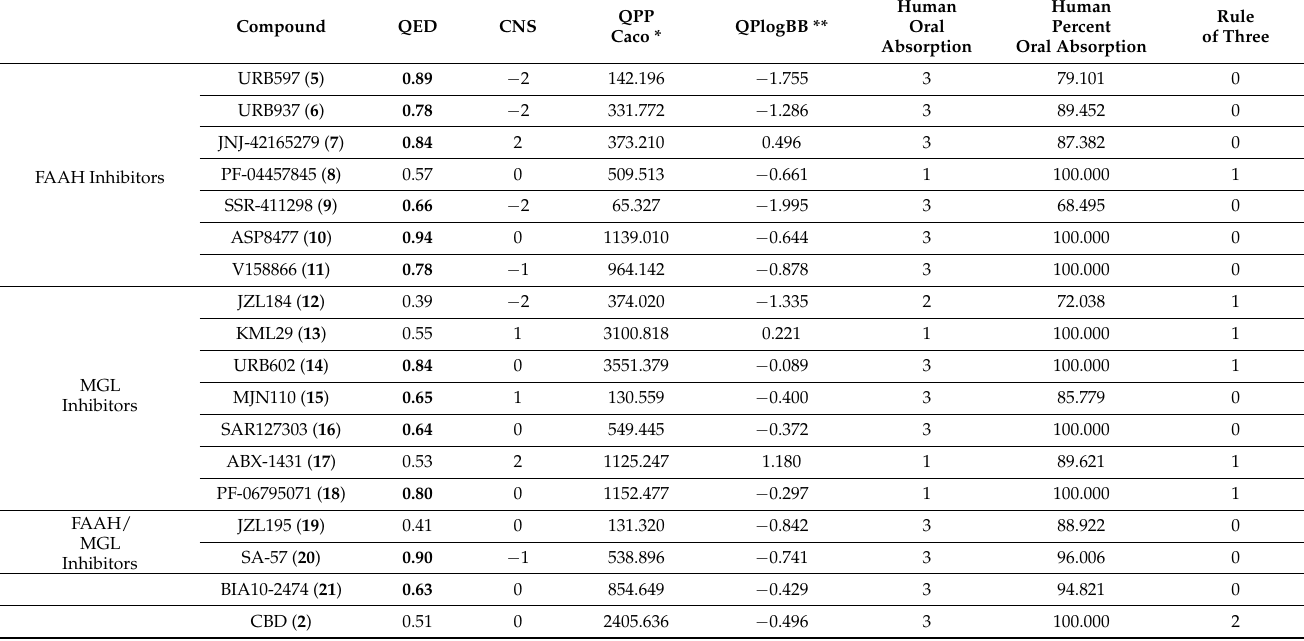
Table 2. Drug-likeness and ADME properties were computed for the compounds under investigation. Notice that the QED values were obtained by using an in-house script based on the paper by Bickerton et al. [126], while the software program QikProp, available from the Schrodinger suite 2022-4 [127], was employed to compute all the other relevant ADME properties. QED values > 0.6 are highlighted in